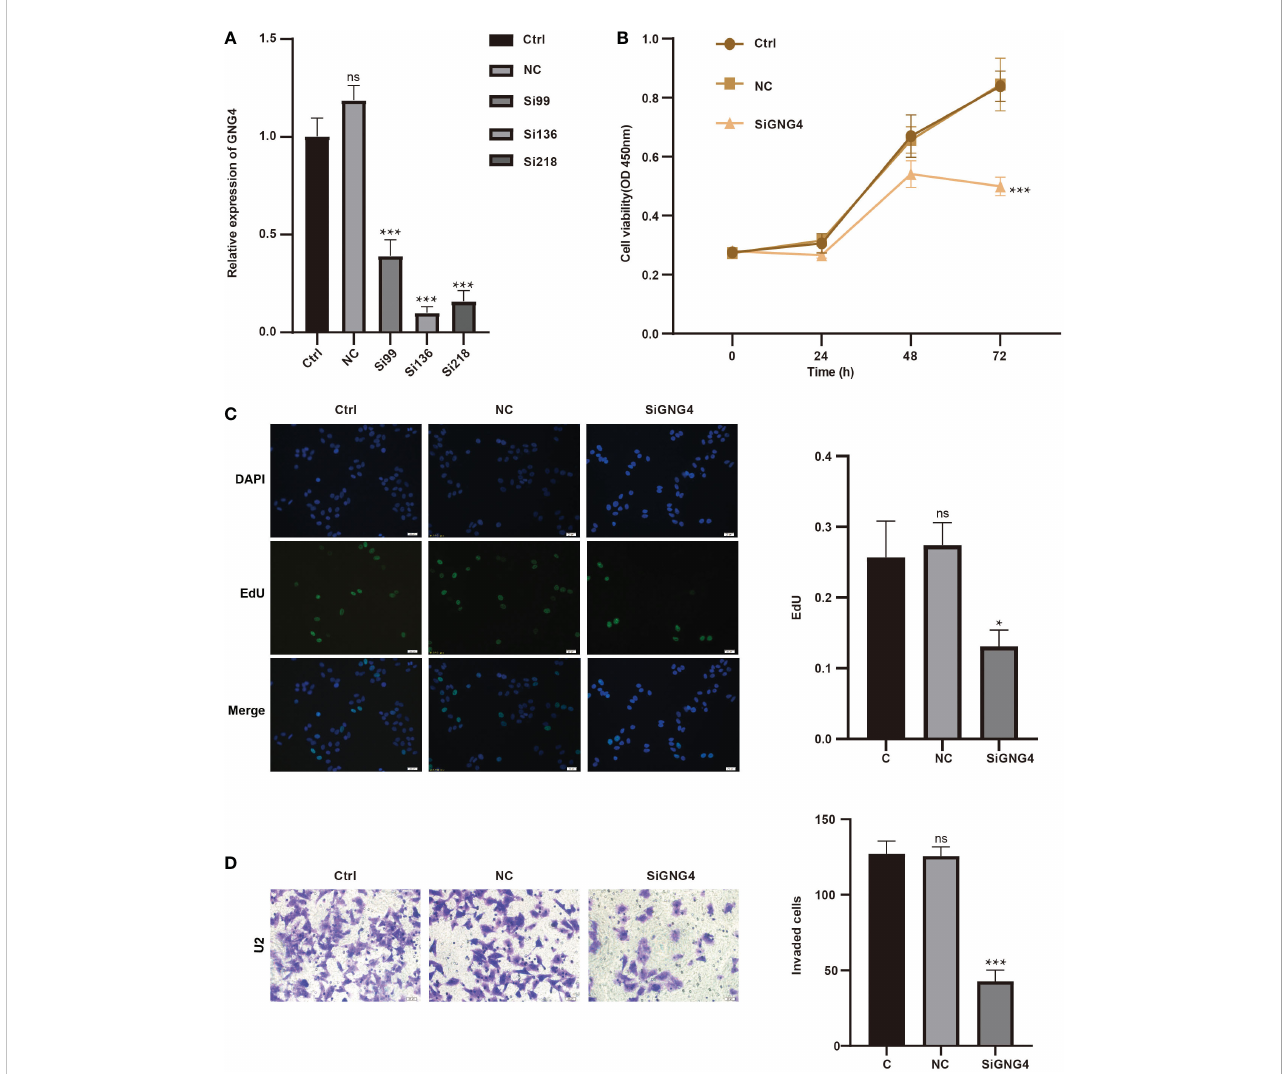
FIGURE 7 GNG4 function in vitro . (A) RT − PCR was used to verify the ef fi ciency of GNG4 silencing. (B) OS cell viability assay after silencing GNG4. (C) EdU assay of OS cells after GNG4 silencing. (D) Invasion assay of OS cells after GNG4 silencing. p<0.001 was considered as signi fi cant difference (***) p ≤ 0.05 was considered as statistical difference (*), ns as no statistical